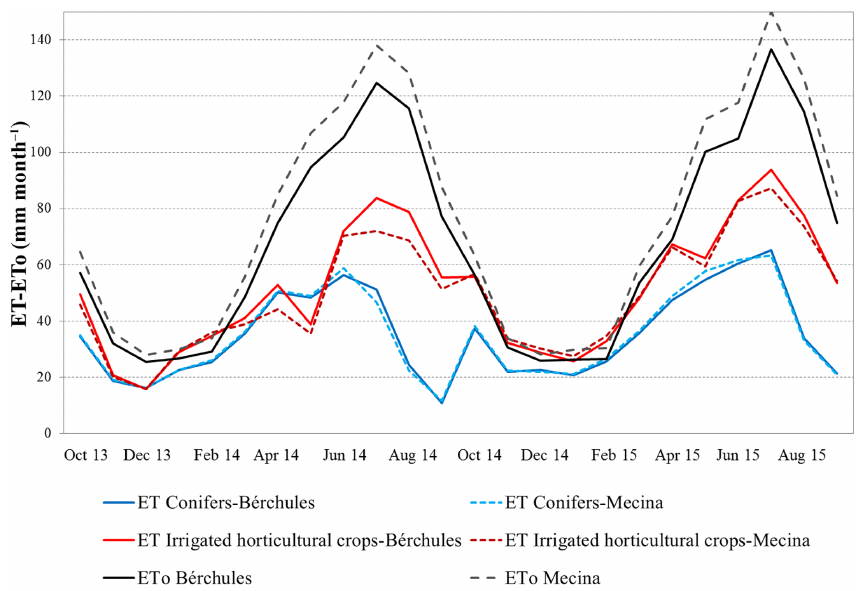
Figure 3. Monthly ET o and estimated ET values of two representative canopies: conifers and irrigated horticultural crops for the Bérchules and the Mecina